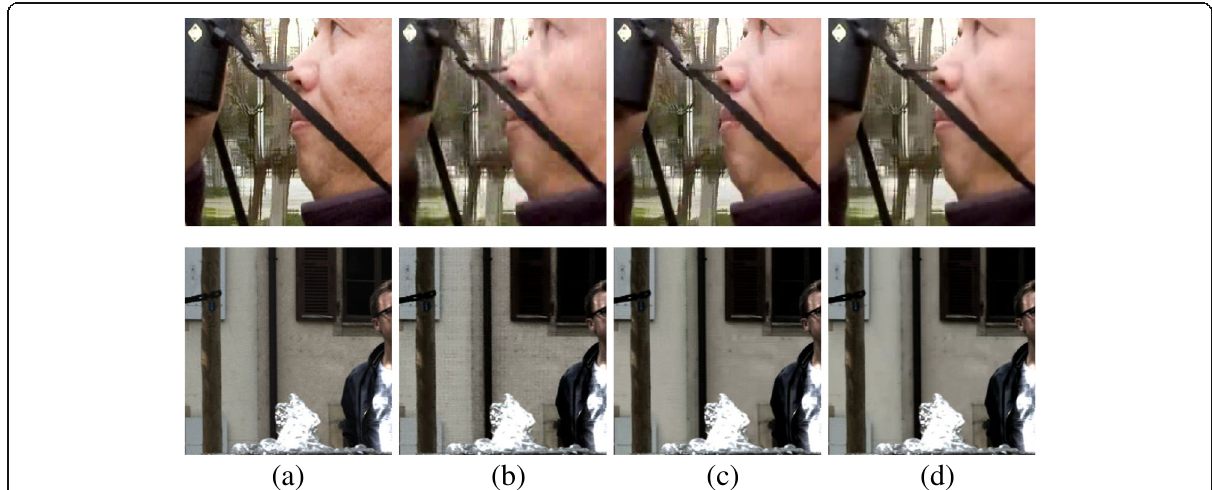
Fig. 8 Visual rendering views from the decoded LF images at a similar bit-rate: a the original image, b HEVC intra-standard, c HEVC-SCC standard, and d the proposed SK-MMSE prediction method. The bit-rate for Jeff is 0.11 bpp and the bit-rate for I09_Fountain_&_Vincent_2 is 0.102